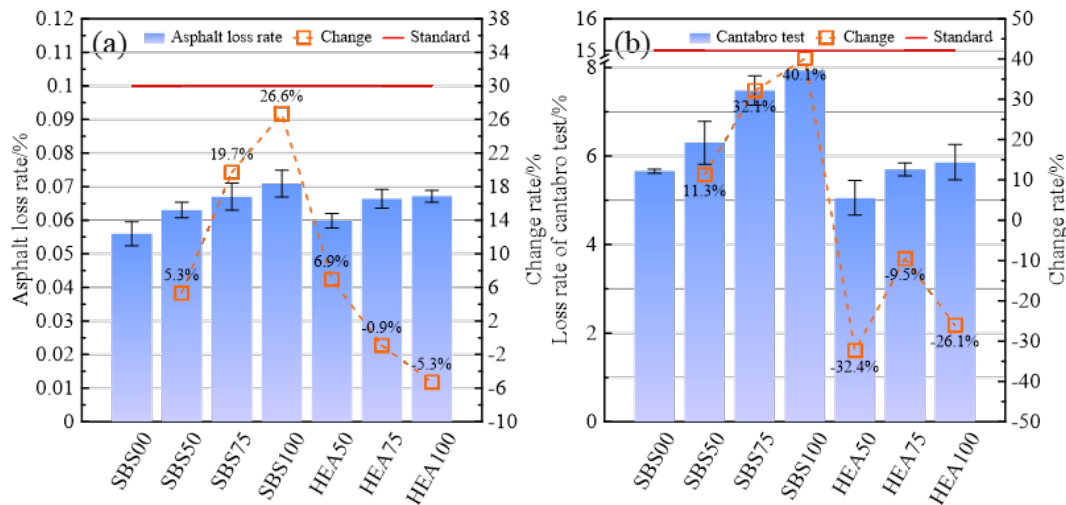
Figure 7. Anti-spalling index of SSAM. ( a ) Asphalt loss rate; ( b ) Cantabro loss Figure 3. The agent interacts with the environment. When the agent observes the environment’s state, the agent chooses action from the list of action pulled by maximum Q-value requirement which is the target of RL algorithms. And then, agent get the reward which depends on the action execution. Environment’s state changes to new state, the next step starts.